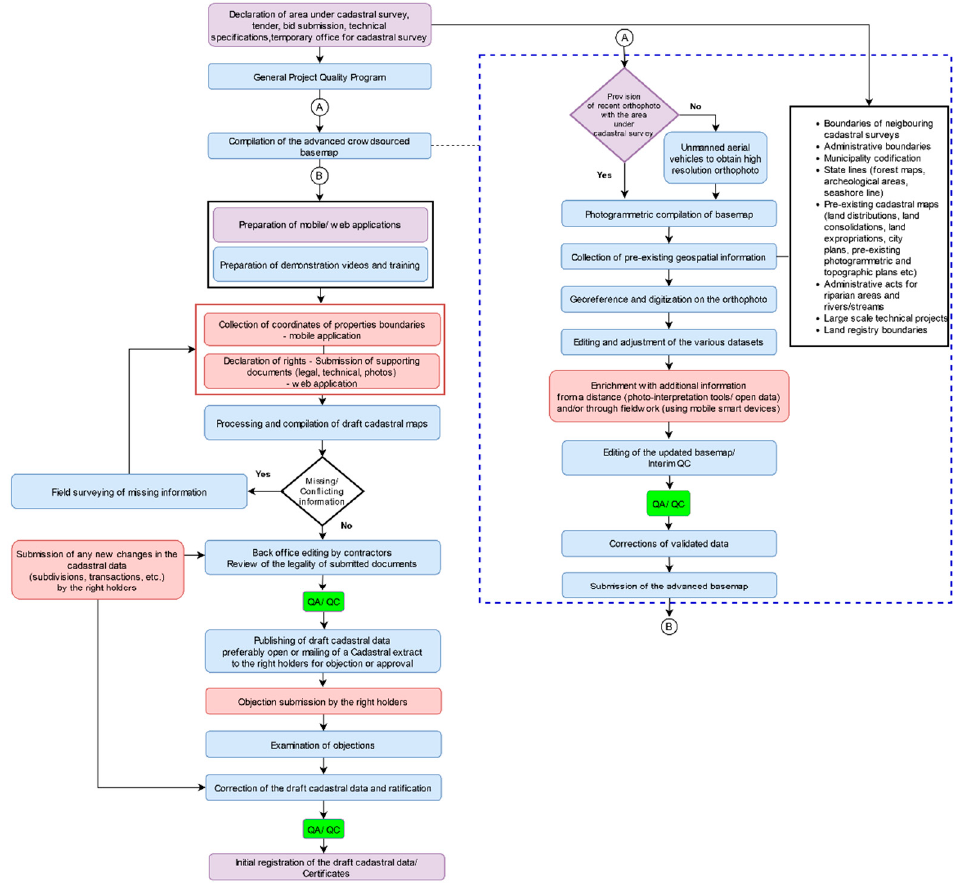
Figure 20. The proposed crowdsourced model enriched with QA/ QC stages: NMCA’s actions (purple); professional’s actions (blue); non-professionals’ actions (pink); QA/QC (bright green).